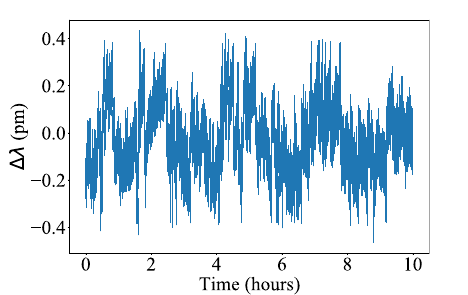
Fig. 5 | Laser wavelength stability. Laser output wavelength fl uctuations about 1083.3300nm (vacuum) as a function of time, over a single night ’ s